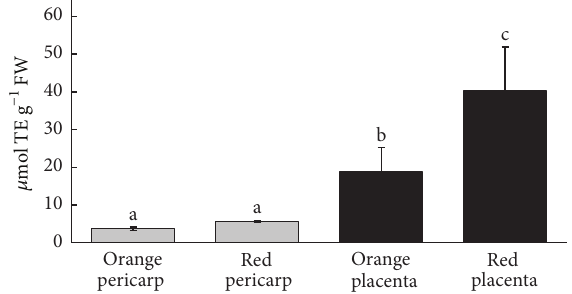
Figure 1: Total phenolic contents in two habanero cultivars at different maturation stages. Values are mean ± SEM, 𝑛 ≥ 3 . Values with distinct letters differ significantly ( 𝑃 < 0.5 ).